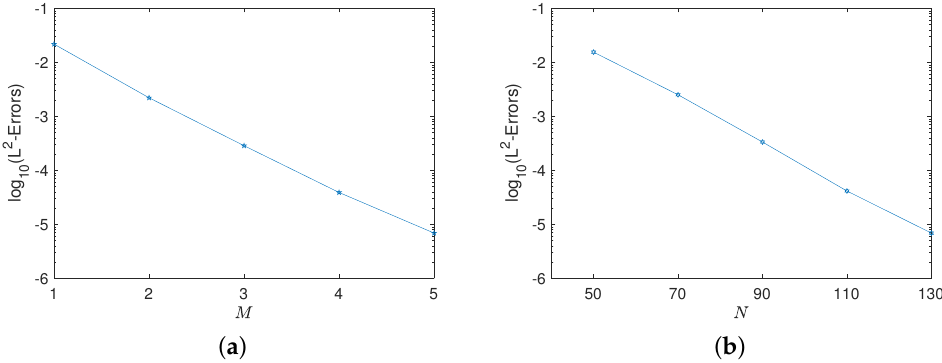
Figure 3. Spectral errors in time and space, respectively, at t = 6 for Example 2. Take a = − 50, b = 50, κ = 0.3, x 0 = − 20. ( a ) Temporal errors versus M with N = 5; ( b ) spatial errors versus N with M =